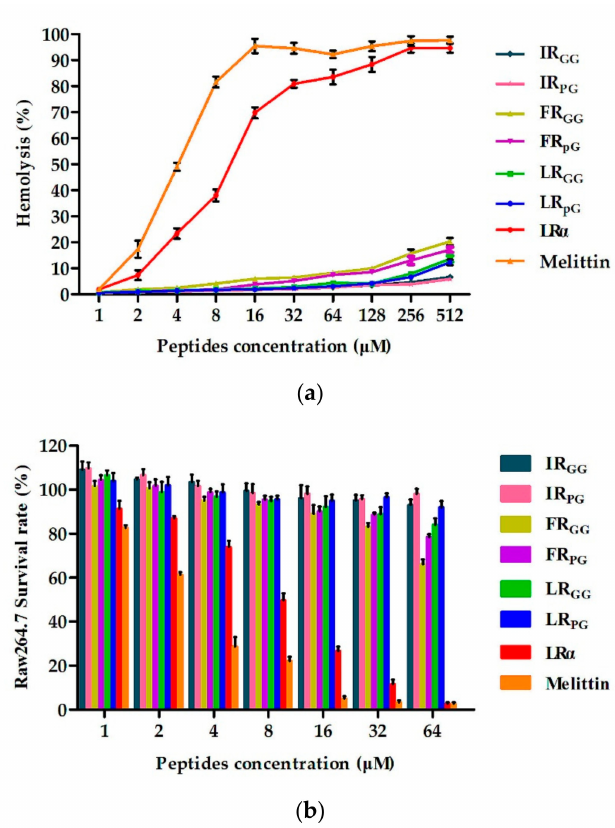
Figure 2. ( a ) Hemolytic activity of designed peptides against human red blood cells (hRBCs); ( b ) cytotoxicity of the designed peptides against RAW 264.7 cells. The diagrams are based on at least three independent